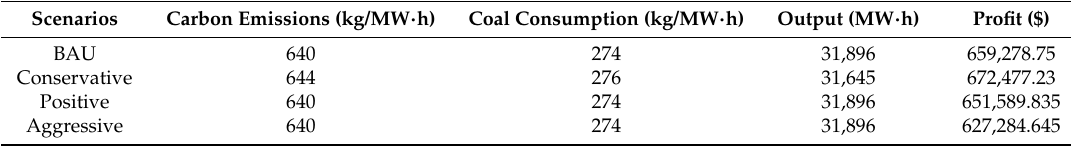
Table 9. Dispatching system optimized results under different